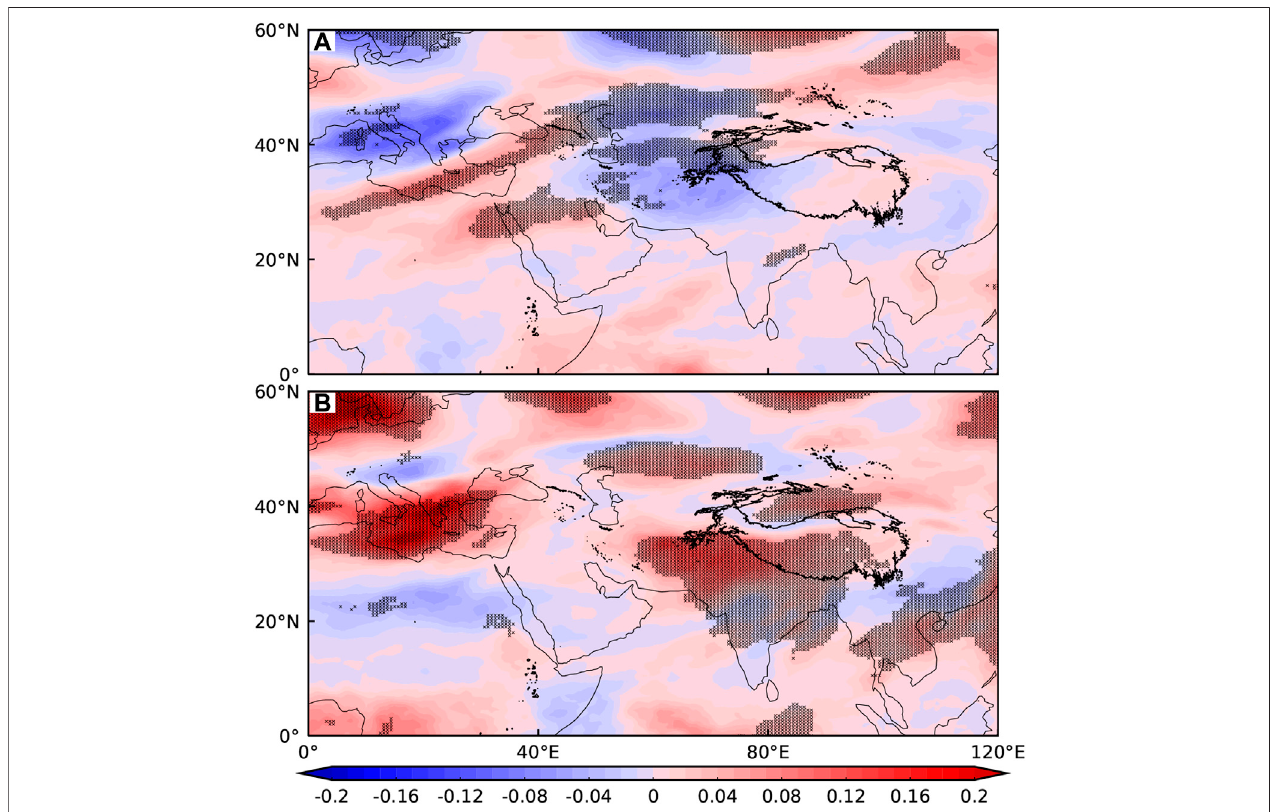
FIGURE 7 | Information fl ow between the tropopause height and the TCO* variation index (TOI) (shading). Black dots represent signi fi cant information fl ows at the 90% con fi dence level; (A) T 1 → 2 : tropopause → TOI and (B) T 2 → 1 : TOI → tropopause .